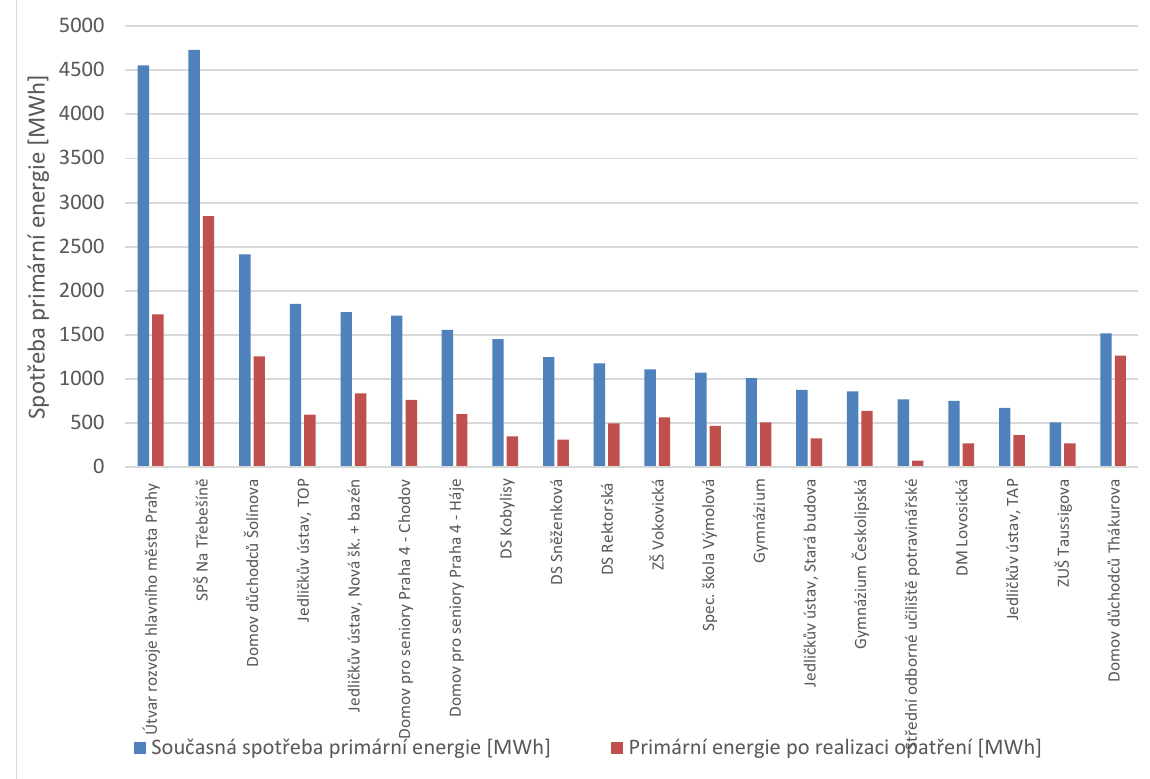
Figure 3: Pořadí doporučené realizace úsporných